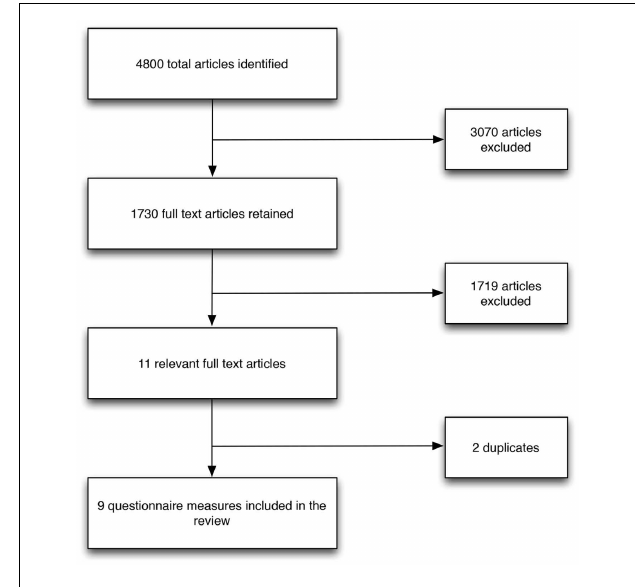
FIGURE 1 | Flow chart